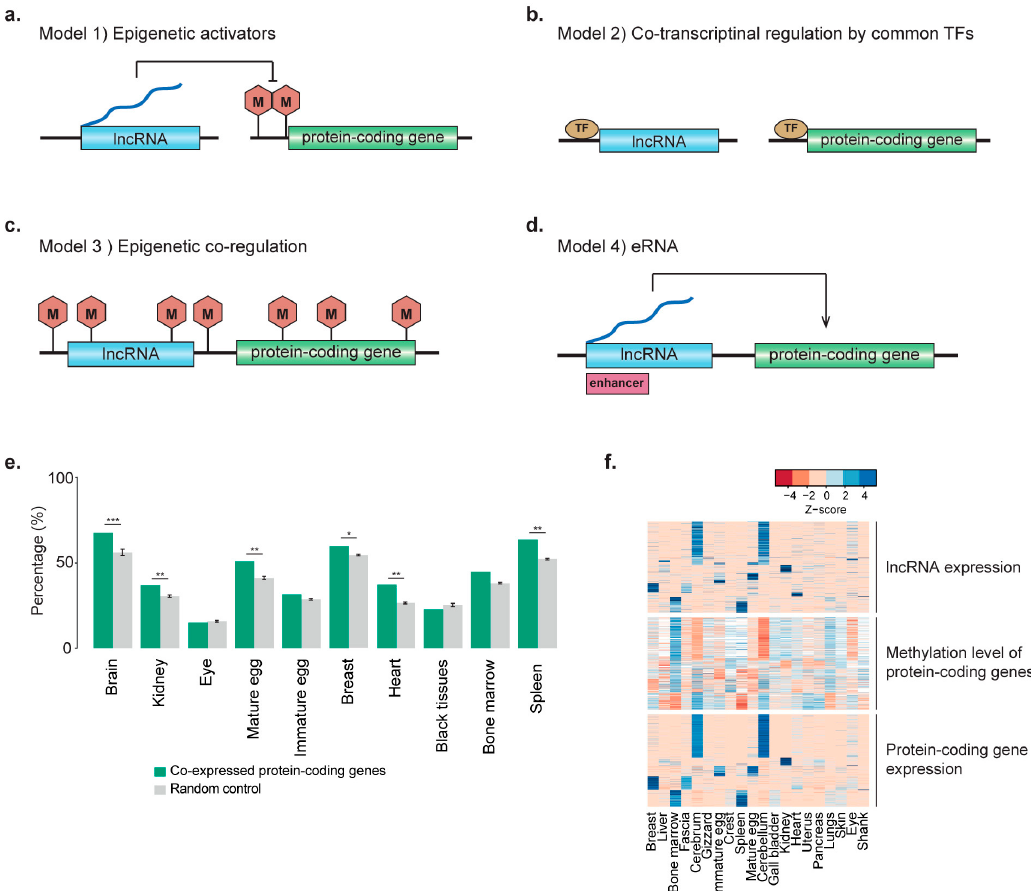
Figure 3. Models of lncRNA and protein-coding gene co-regulation and lncRNAs as epigenetic activators. ( a ) LncRNAs as epigenetic activators that suppress the methylation level in the promoter of protein-coding genes. ( b ) Transcriptional co-regulation of lncRNA and protein-coding genes by common TFs. ( c ) Epigenetic co-regulation of neighboring lncRNA and protein-coding genes. ( d ) eRNAs that activate the expression of neighboring protein-coding genes. ( e ) Proportions of lncRNAs with expression levels correlated with the methylation level in the promoter of co-expressed protein-coding genes (dark green) in each cluster are shown in bar graphs. The numbers were compared to the mean methylation level of randomly selected protein-coding genes. To test the significance of the enrichment of lncRNAs as epigenetic activator candidates, 1000 number-matched random cohorts were compared to the original numbers (* p ≤ 0.05, ** p ≤ 0.01, *** p ≤ 0.001). ( f ) LncRNAs as epigenetic activators whose expression levels are negatively correlated with the methylation level in the promoters of protein-coding genes, which in turn are negatively correlated with the level of protein-coding gene expression, as shown in the heatmaps. The key indicates the z-score range of the expression values. White indicates N.A.